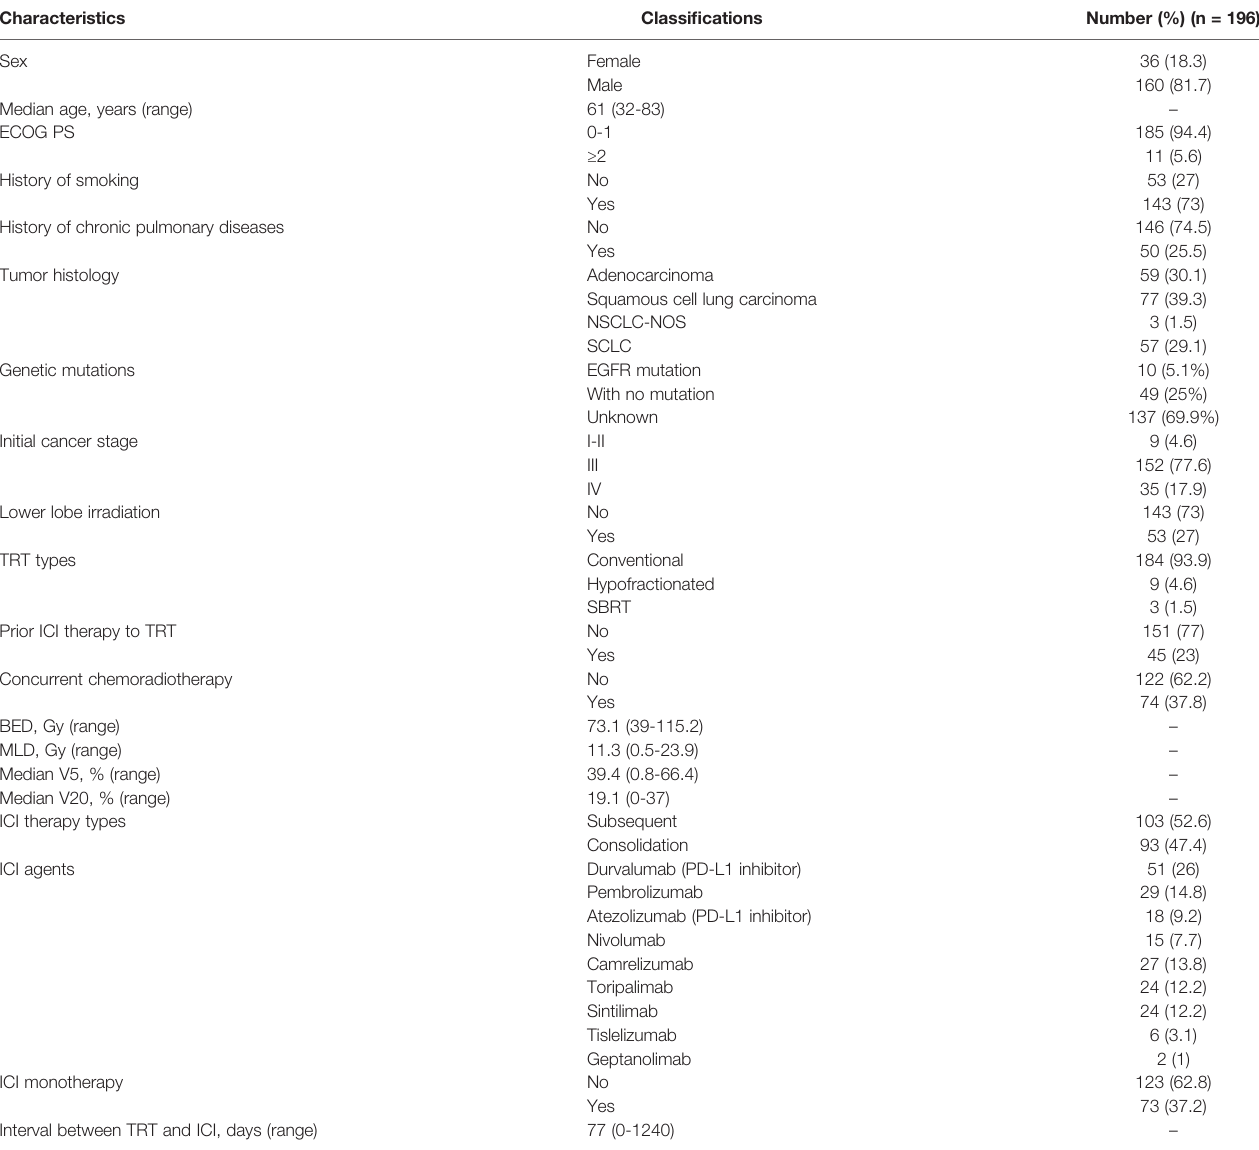
TABLE 1 | Characteristics of patients, TRT and ICI